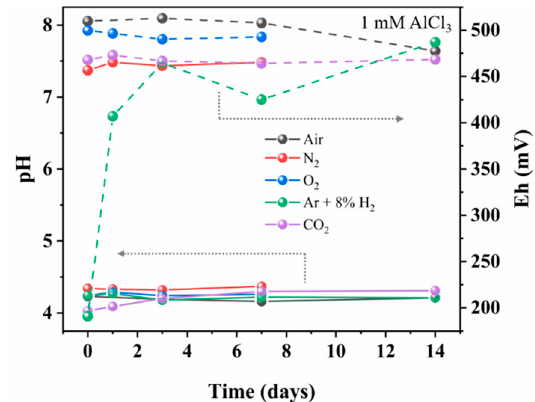
Figure 5. Effect of time on pH (solid line) and Eh (dashed line) of aqueous solution containing nanobubble of different kind of gases (N 2 , O 2 , Ar + 8%H 2, air and CO 2 ) in ( A , A’ ) deionized water, ( B ) 1 mM NaCl aqueous solution, ( C ) 1 mM CaCl 2 aqueous solution and ( D ) 1 mM AlCl 3 aqueous solution.